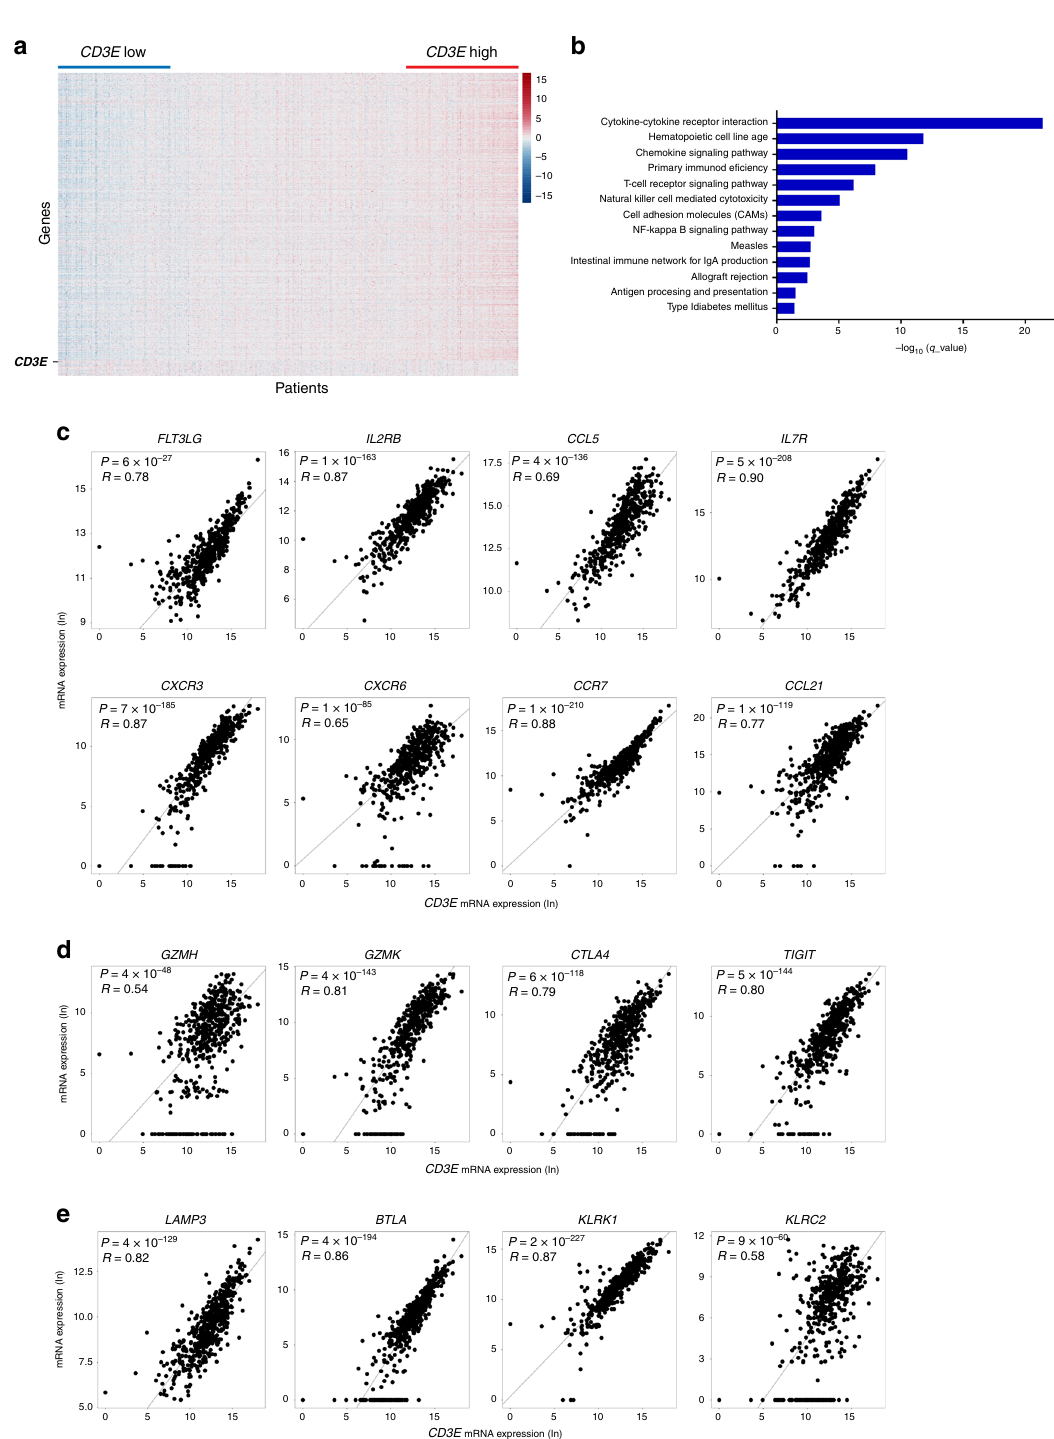
Fig. 1 CD3E expression is associated with antitumor immune responses in human neuroblastoma. a Heatmap of the normalized expression of immune genes ordered from left to right by increasing levels of CD3E expression of 498 NB patients from the SEQC-NB available in the GEO database. b Gene ontology term enrichment analysis performed by DAVID Bioinformatics Resources (https://david.ncifcrf.gov/) reveals 13 statistically signi fi cant (Benjamini – Hochberg adjusted P value <0.05) biological processes controlled by upregulated genes among patients with high CD3E expression. c – e Correlation of CD3E expression with the indicated genes in NB patients. Gene transcripts reported to be associated with increased immune cell in fi ltration, immune cell traf fi cking, and immune functional status 15,80 – 82 were studied in the SEQC-NB dataset. Genes that met the following criteria: (i) a correlation coef fi cient (R) greater than or equal to at least 0.4 with statistical signi fi cance ( P < 0.05), (ii) a signi fi cantly different expression between patients with high and low CD3E expression, and (iii) showing consensus in the Nanostring cohort, were displayed. Robust F-test (two-sided) on the robust regression fi t of a linear model was used for data analysis. c Cytokines and chemokines involved in immune cell traf fi cking. d Activation and exhaustion molecules. e DC and NK-cell function markers. Correlations were assessed measuring the coef fi cient of determination of a robust linear regression model fi t on the data (see “ Statistical analysis ” ). No adjustment was required unless otherwise stated. Statistically signi fi cant P values are